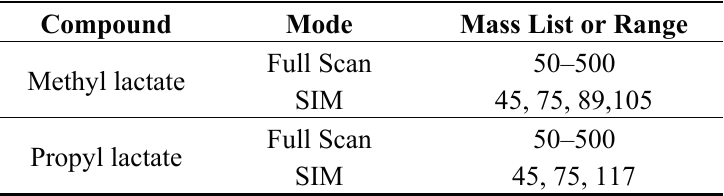
Table 2. The monitored ions and other